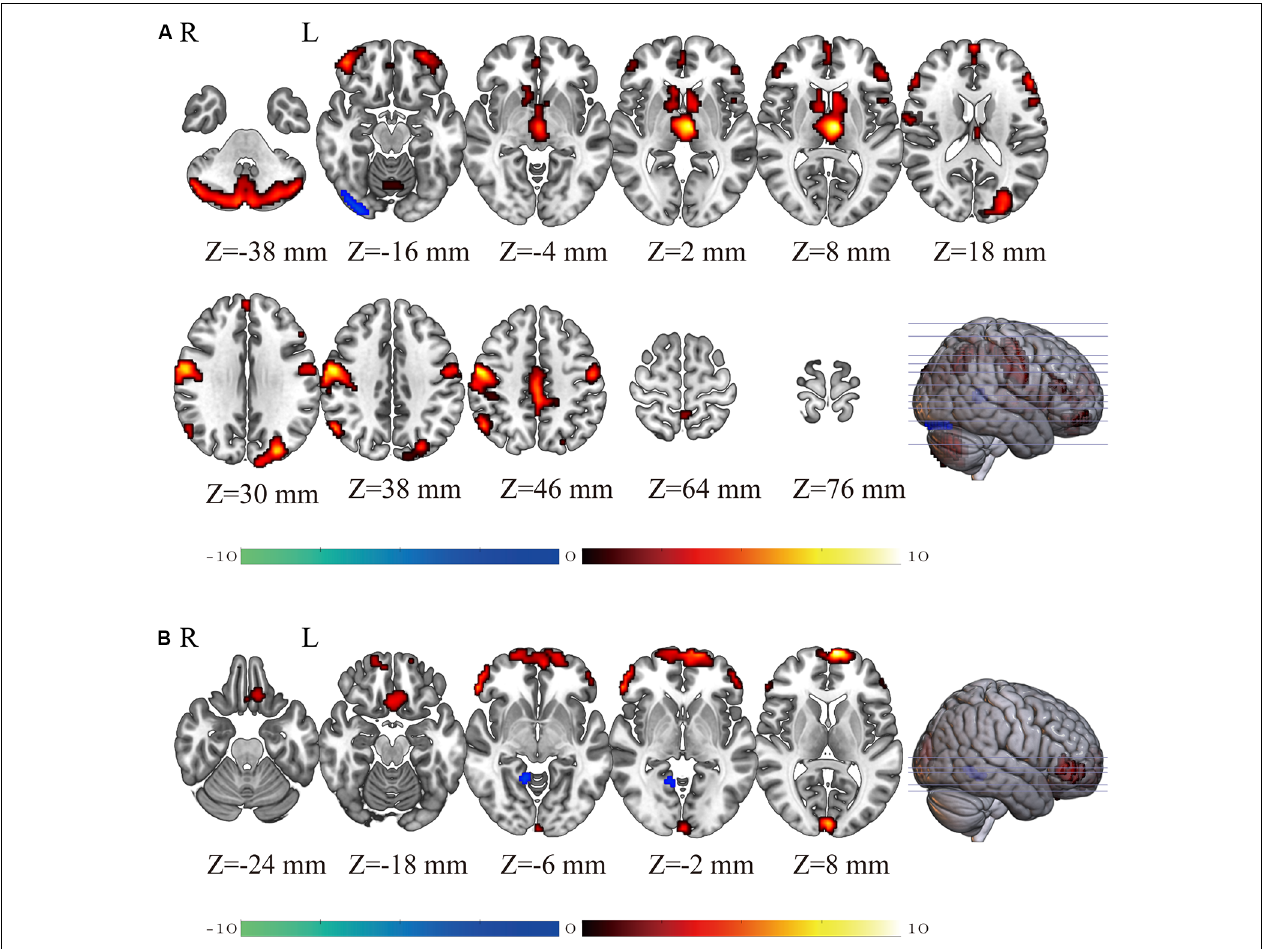
FIGURE 1 | The brain maps showing gender differences (Female-Male) in gray matter volume (GMV; panel A ) and regional homogeneity (ReHo; panel B ) detected using two-sample t -tests. The T -values of the voxels showing significant differences are indicated in color. Warm colors (red-yellow) indicate higher GMV (panel A ) or higher regional homogeneity (ReHo; panel B ) in females than in males and cold colors (blue-green) indicate higher GMV (panel A ) or higher ReHo (panel B ) in males than in